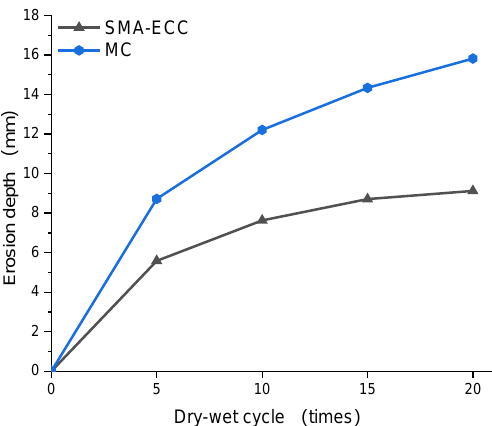
Figure 11. Change law of chloride ion erosion depth of corroded specimens.